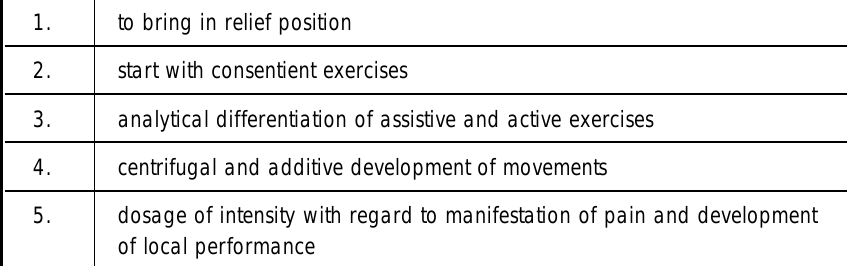
Table 1: Main Criteria in Early Functional Therapy of Reflex Sympathetic Dystrophy.